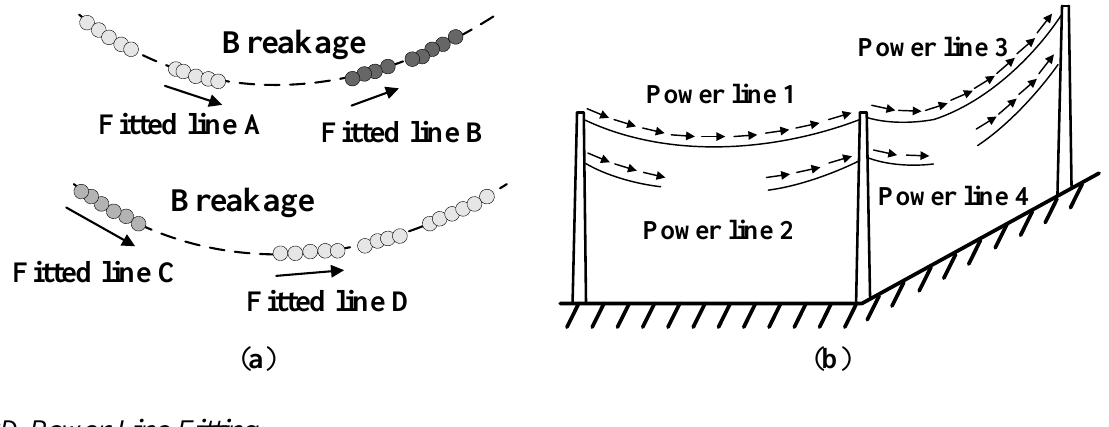
Figure 7. Cluster recovery. ( a ) High curvature with large occlusions. ( b ) Identification of broken clusters.